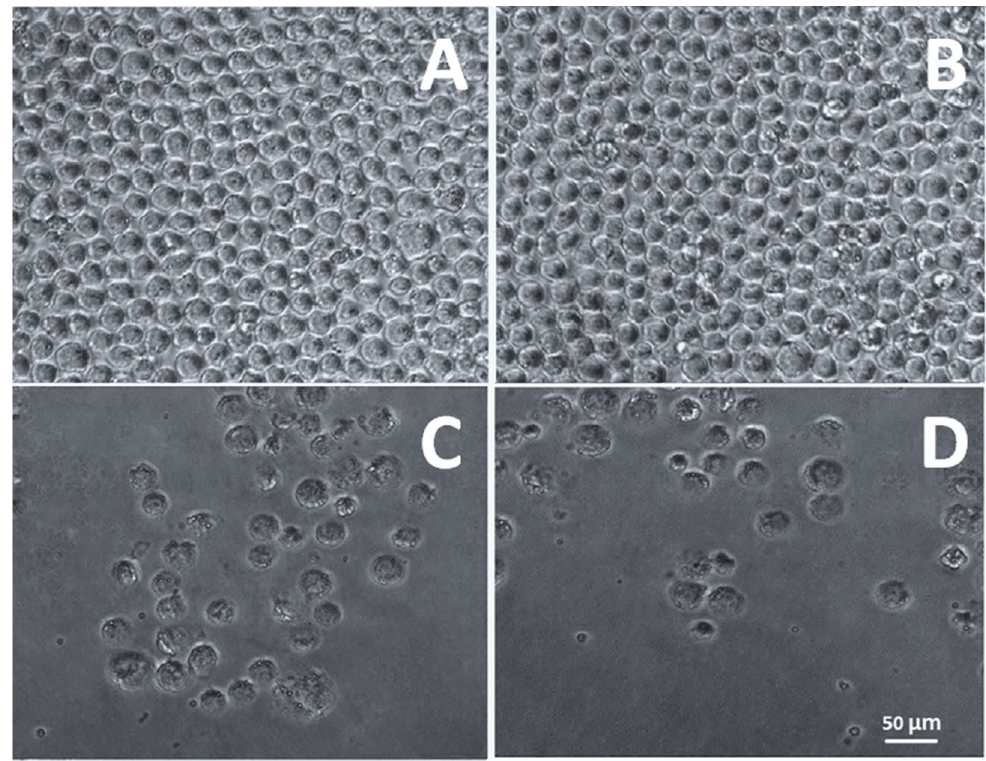
Figure 11. Morphological cellular appearance of HL 60 cells exposed for 72 h to materials and formulation such as ( A ) no treatment positive control, ( B ) only drug cytarabine, ( C ) neat TINPs, and ( D ) cytarabine ‐ loaded TINPs.